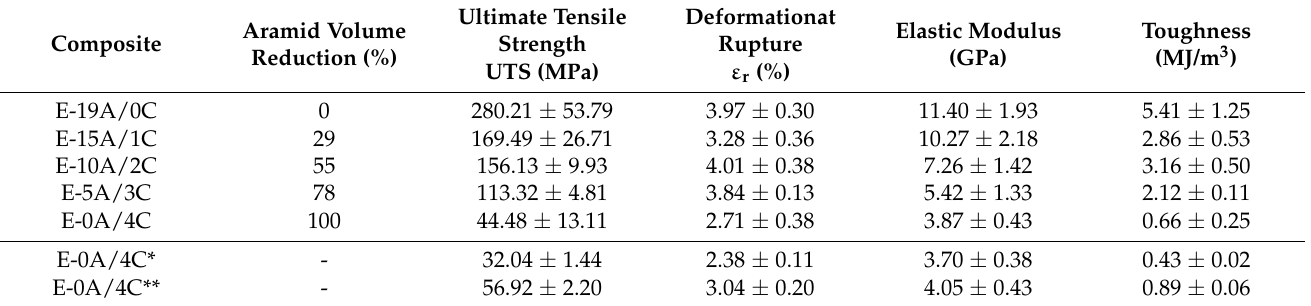
Table 4. Composite mechanical properties obtained from tensile test.